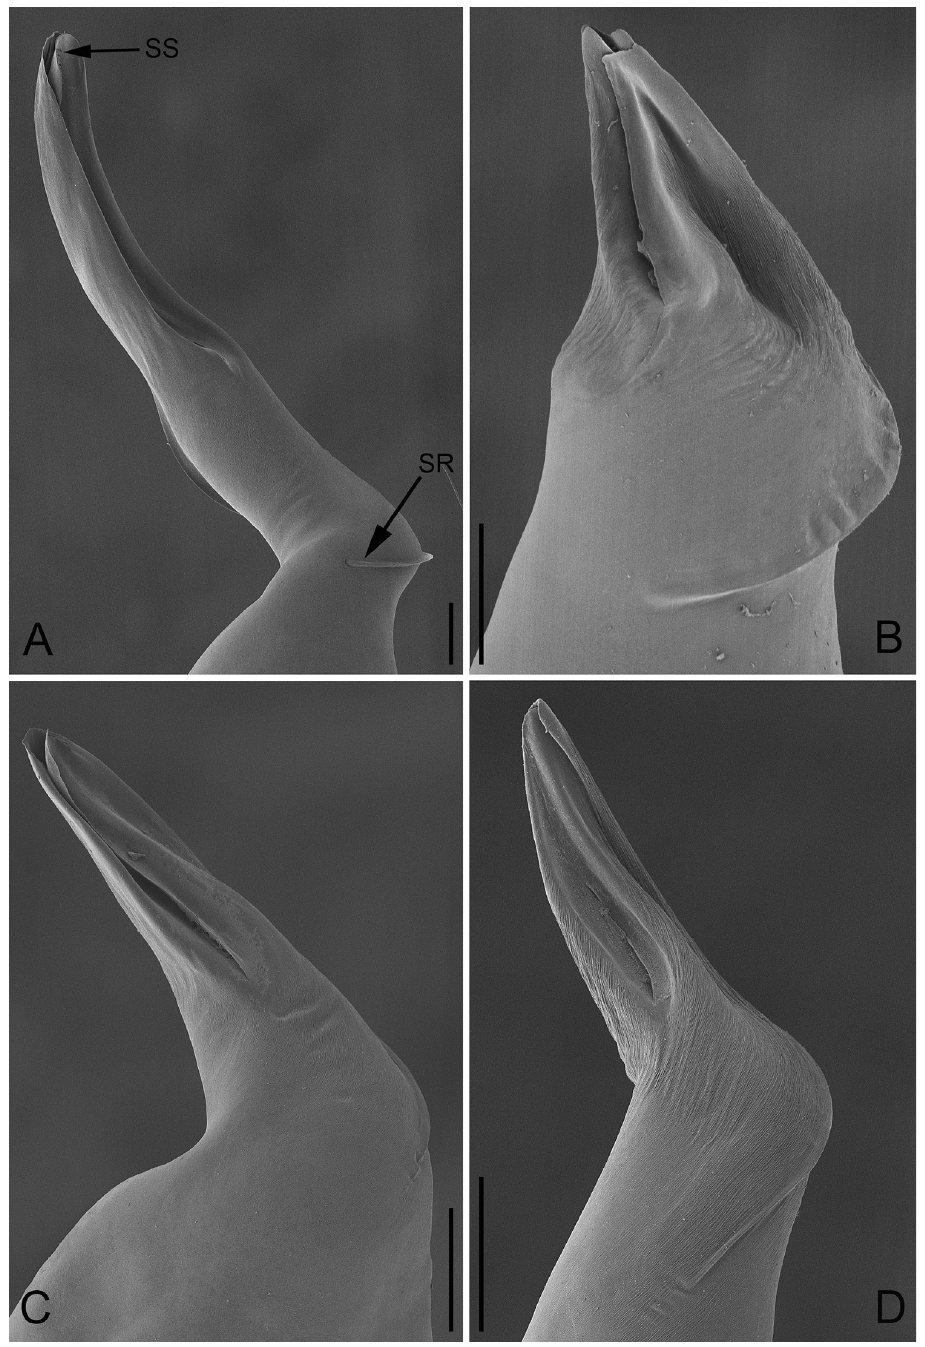
Figure 10. Retrolateral view of embolus of P. bailongensis ( A ); P. cunfengensis sp. n. ( B ); P. podiensis sp. n. ( C ); P. qingfengensis sp. n. ( D ). Scale bars: 0.05